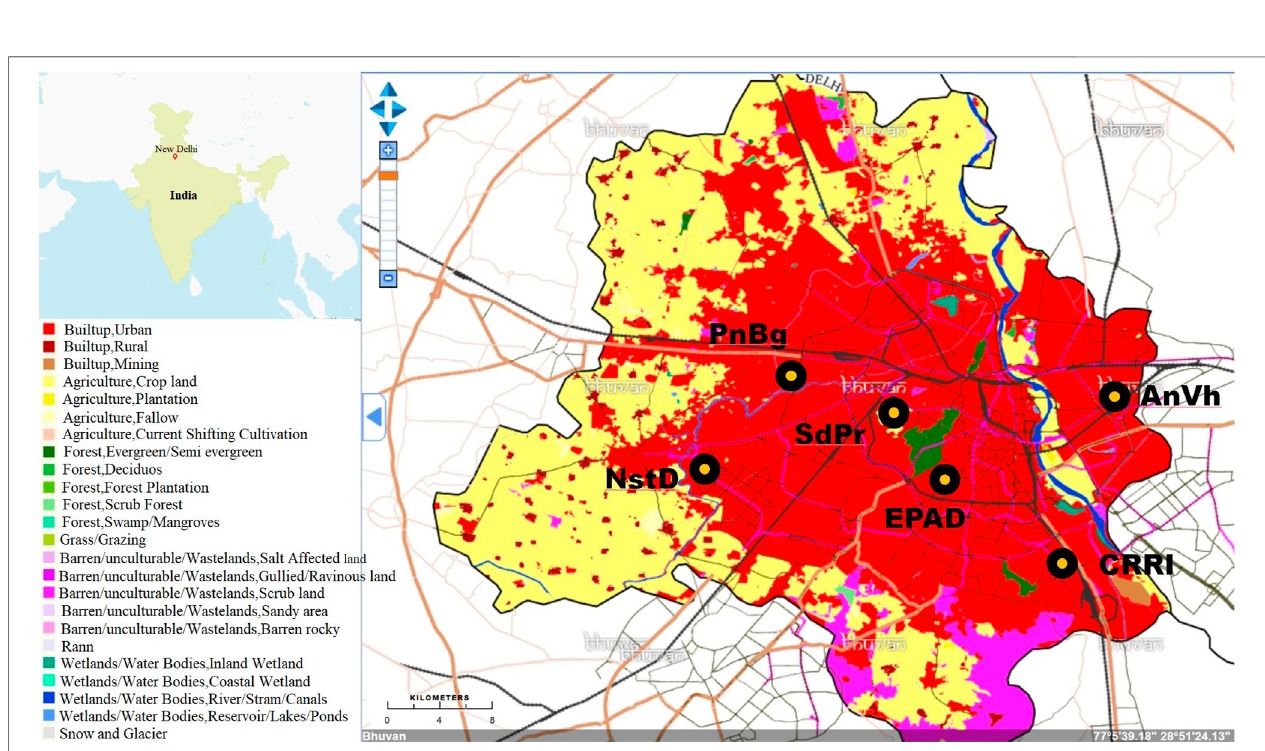
FIGURE 1 | Map of Delhi showing the study locations. The Land Use Land Cover (LULC) map is downloaded from Bhuvan(https://bhuvan-app1.nrsc.gov.in/ thematic/thematic/index.php). The study sites are: Anand Vihar (AnVh), Punjabi Bagh (PnBg), Shadipur (SdPr), Central Road Research Institute (CRRI), NSIT-Dwarka (NstD), and EPA/US Embassy Delhi